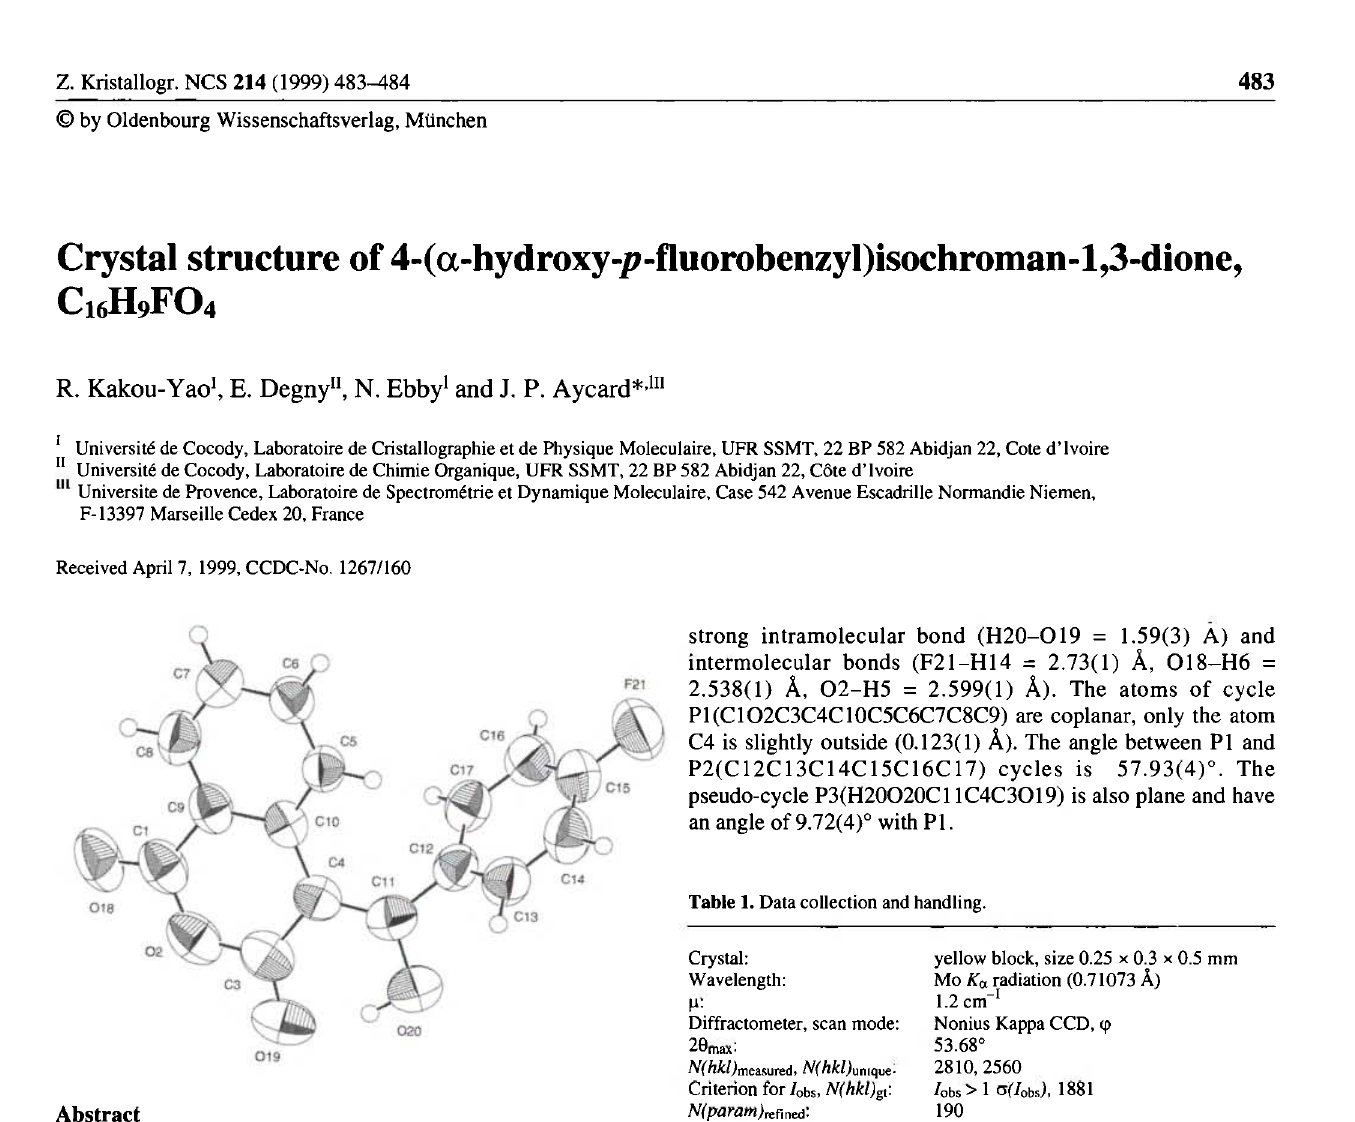
Table 1. Data collection and handling.